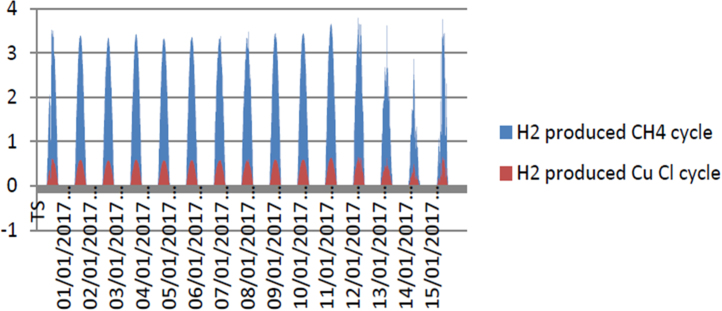
Hydrogen produced from CH4 cycle and Cu–Cl cycle.